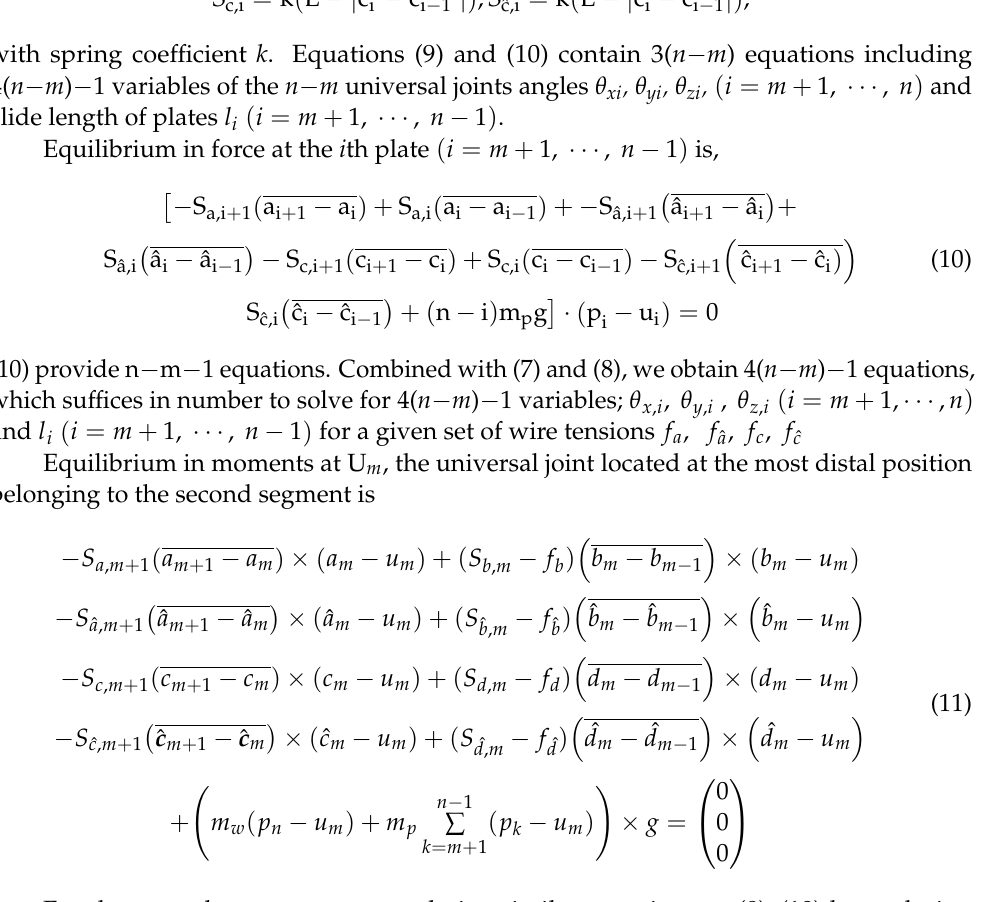
Figure 18. Pretension mechanism structure. Wire tensions 𝑓 𝑎 , 𝑓 𝑎̂ , 𝑓 𝑐 , 𝑓 𝑐̂ , 𝑓 𝑏 , 𝑓 𝑏̂ , 𝑓 𝑑 , 𝑓 𝑑̂ . are determined according to four motor an- gles 𝜙 𝑎 , 𝜙 𝑏 , 𝜙 𝑐 , 𝜙 𝑑 (Figure 19) As 𝑓 𝑎 = 1 2 𝑘 𝑝 (2Ū 𝑝𝑎 + 𝜆𝜙 𝑎 4𝜋 + 1 2 ∑